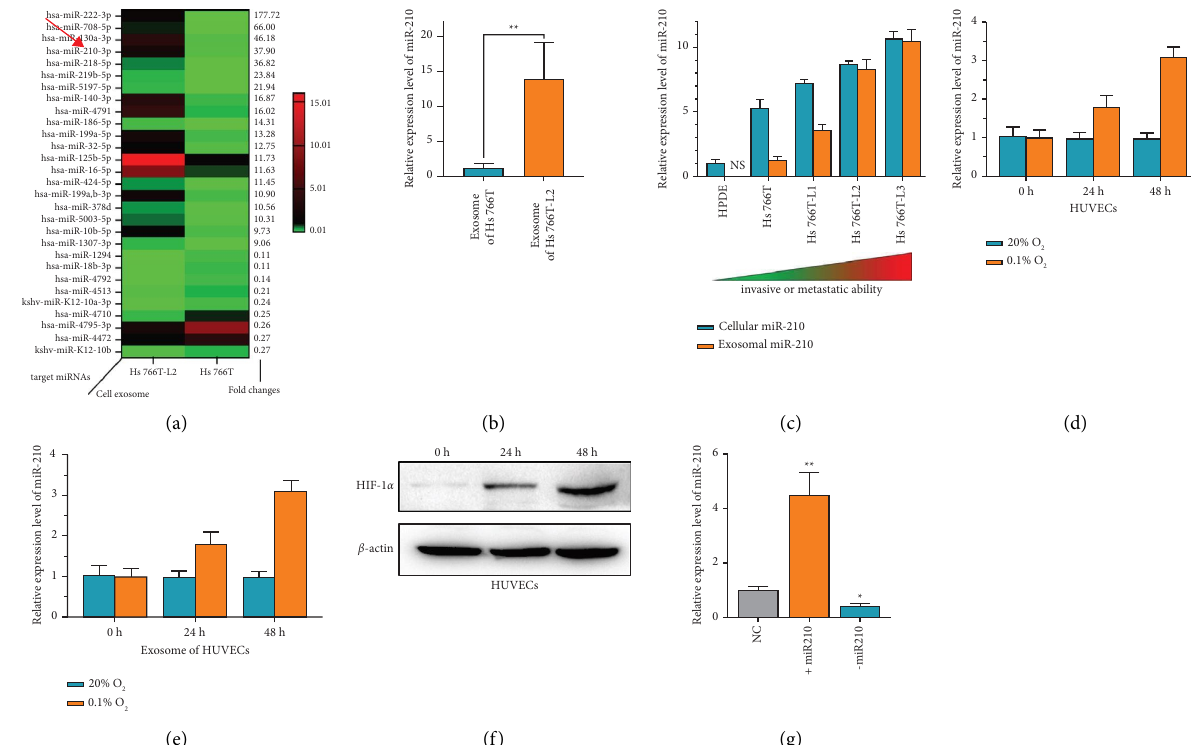
Figure 2: Te identifcation of miR-210 in PDAC exosomes. (a) Heatmap of the screened miRNAs of exosomes from Hs766Tand Hs766T- L2 cells. Te fold change in each screened miRNA is attached in the right column. (b) Relative miR-210 expression in exosomes of Hs766T and Hs766T-L2 cells was measured by qRT-PCR. (c) Relative miR-210 expression in the indicated PDAC or normal cell lines was measured by qRT-PCR. (d) Relative miR-210 expression in the indicated HUVECs was measured by qRT-PCR. (e) Relative miR-210 expression in the indicated exosomes of HUVECs was measured by qRT-PCR. (f) Relative HIF-1 α expression in the indicated HUVECs was measured by WB analysis. (g) Relative expression of miR-210 in the indicated treated cells was measured by qRT-PCR. +miR-210, miR-210 was overexpressed by miR-210 lentivirus; − miR-210, miR-210 was inhibited by miR-210